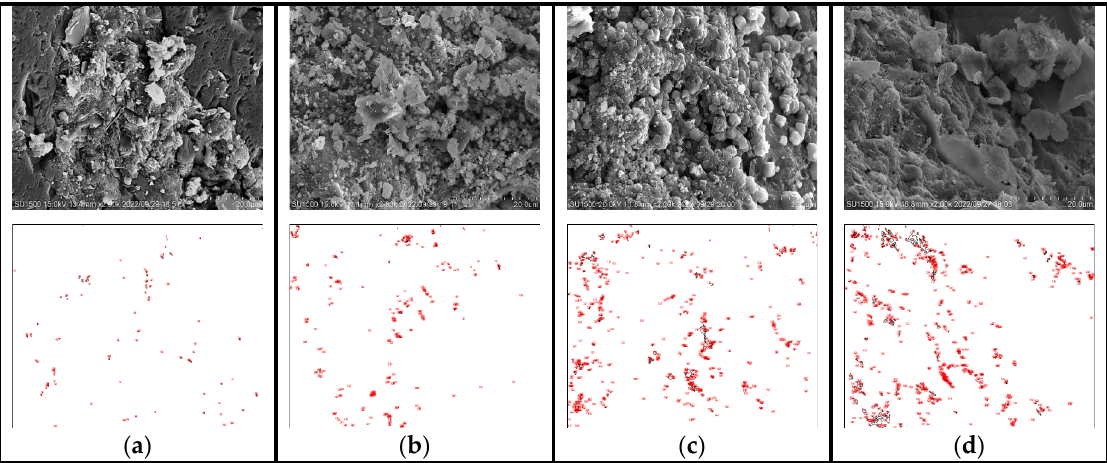
Figure 15. Micromorphology and the correlating pore outline drawing of SAP-0.150% with different cycles times: ( a ) 0, ( b ) 25, ( c ) 50, ( d ) 75. Table 8. Statistical summary diagram of